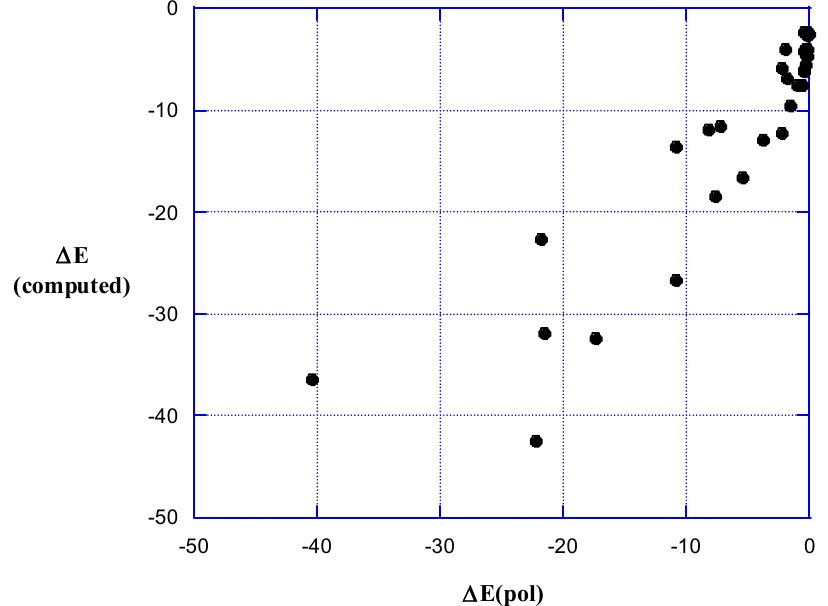
Figure 7. Computed ∆ E plotted against ∆ E(pol) obtained with Equation (6), in kcal / mol, for the π -hole interactions in Table 2.